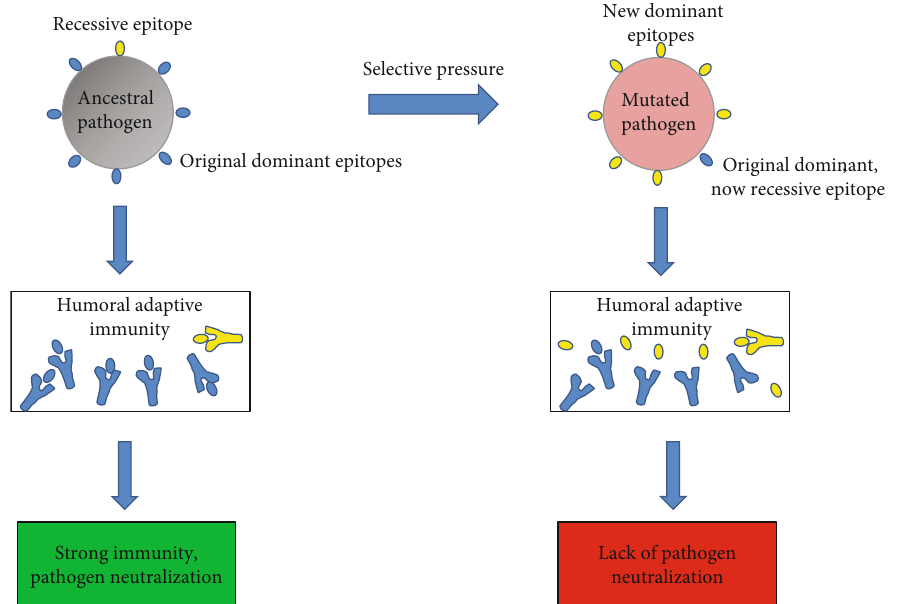
Figure 1: The “ original antigenic sin. ” When the body fi rst encounters a pathogen, it produces e ff ective antibodies against its dominant antigen and thus eliminates the pathogen. Selective pressure can originate pathogens with new dominant antigens, with the original antigens now being recessive. In this case, the immune system still produces the former antibodies against the old “ now recessive antigen ” and develops antibodies against the new dominant one scarcely. The results are the production of ine ff ective antibodies and generation of weak